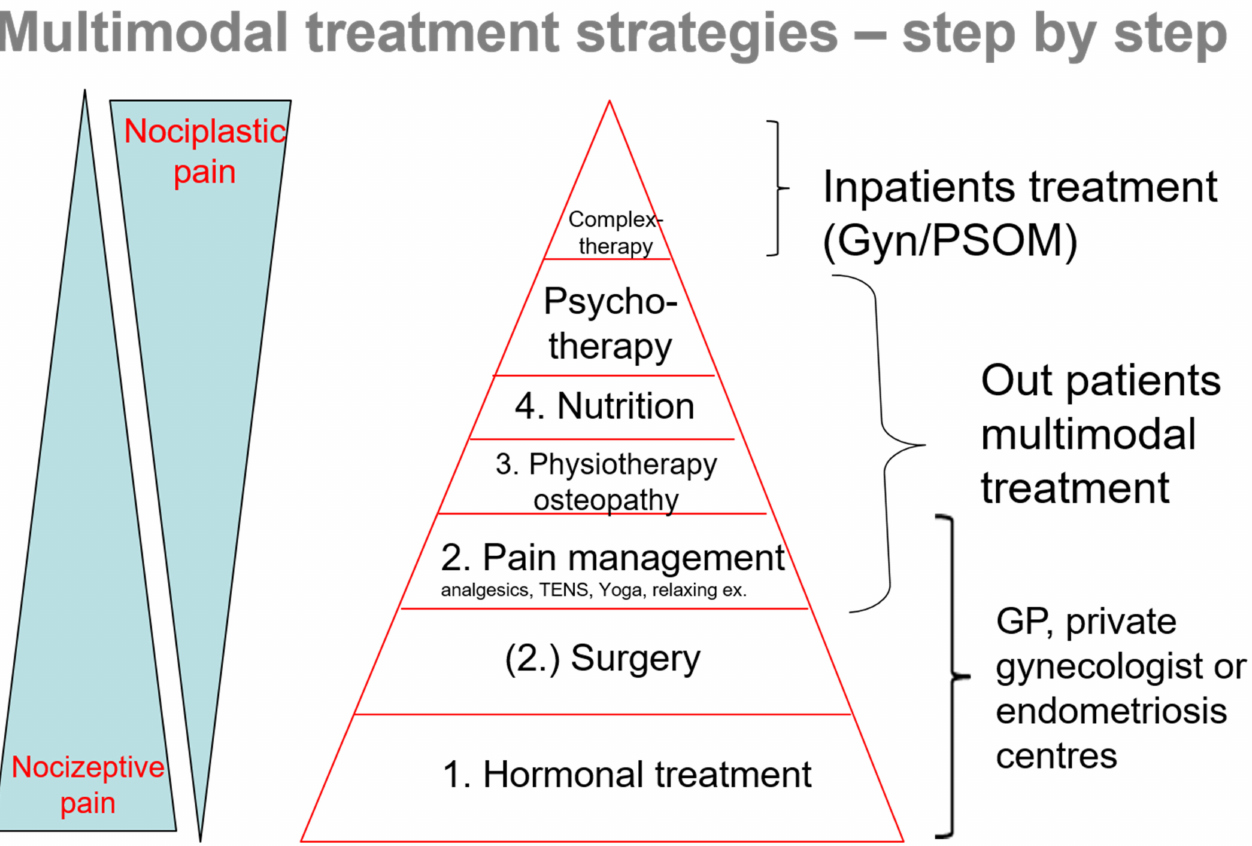
Figure 2. Multimodal treatment strategies—step-by-step: the basis forms hormonal treatment, surgery is optional, facultative is pain management in addition to physiotherapy/osteotherapy, nutrition and in more complex cases psychotherapy and gynecological/psychosomatic inpatient treatment (Gyn/PSOM) as interdisciplinary